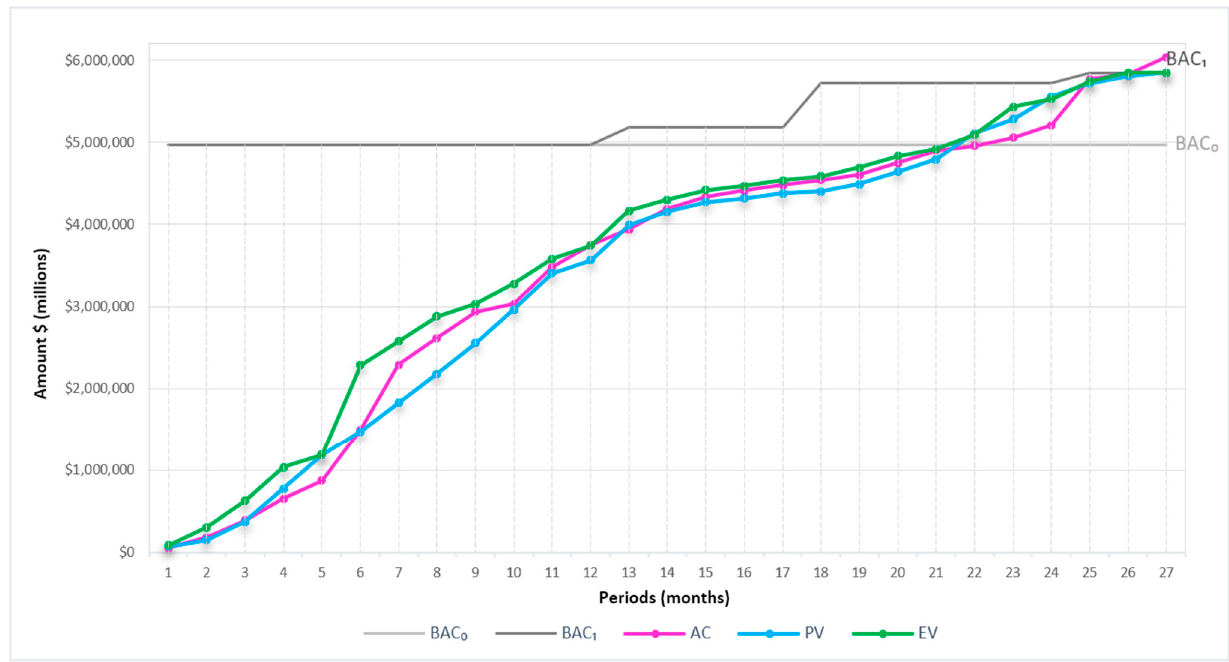
Figure 3. Basic metrics PV, EV, and AC: Project 001 (source: Proaño-Narváez).